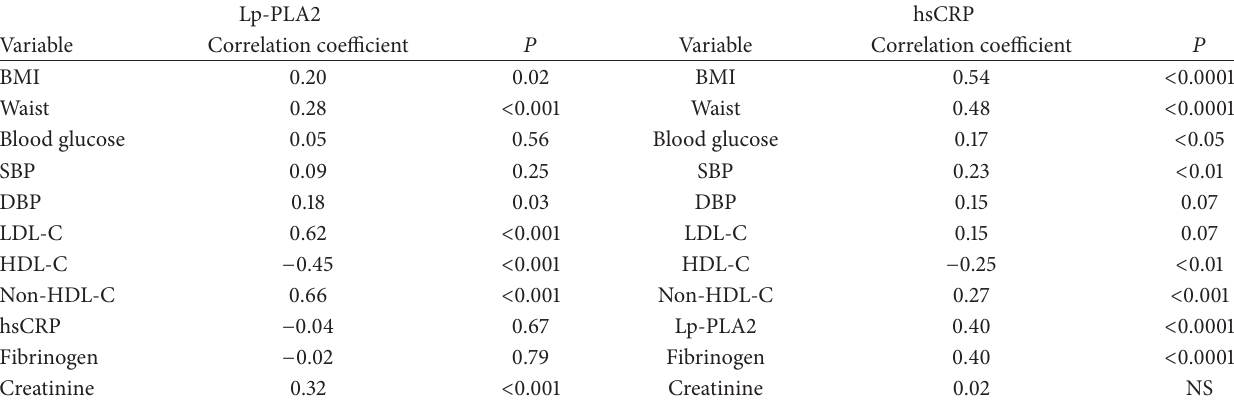
Table 3: Correlation coefficients of Lp-PLA2 with demographic variables, lipid factors, blood glucose, blood pressure, hsCRP, and fibrinogen.